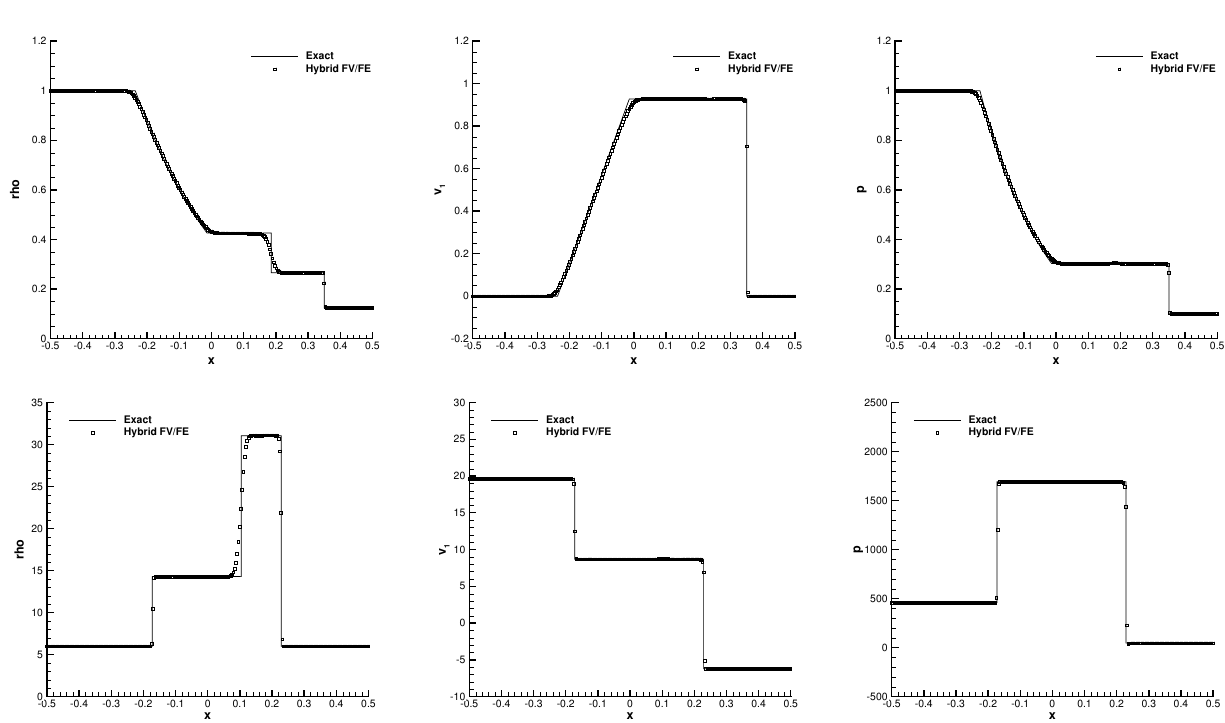
512 32 32 primal simplex × × ×